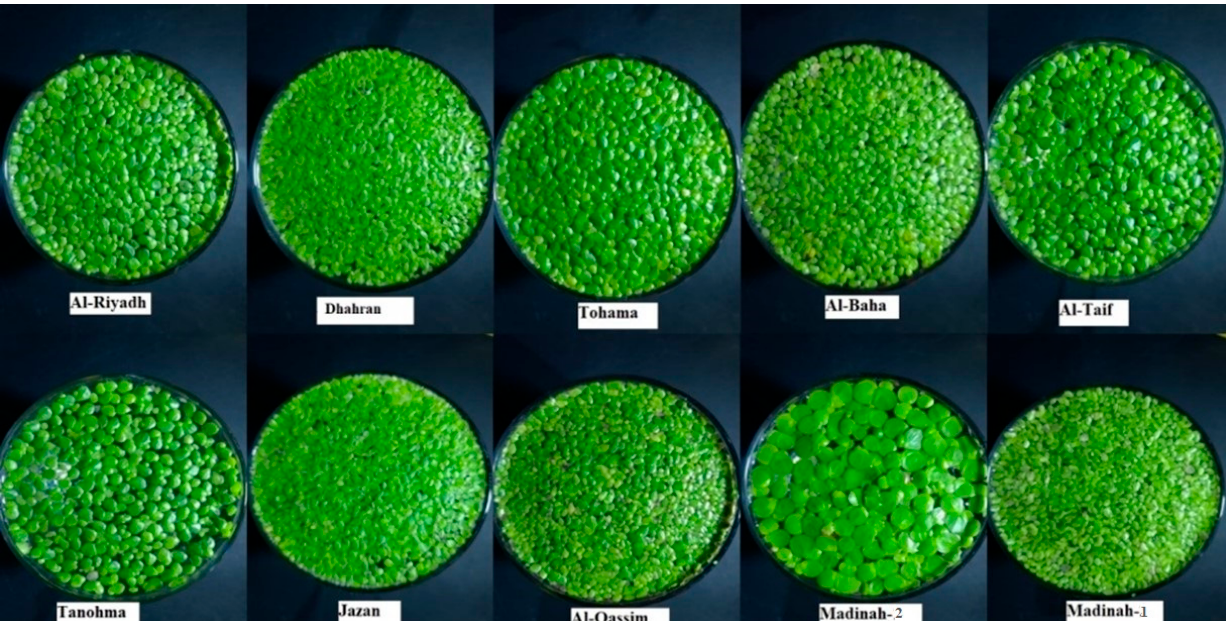
Figure 1. Duckweed clones collected from Saudi Arabia were used for morphological characterization and molecular identification. Table 1. Qualitative morphological traits for studied duckweed clones of the ten locations of Saudi Arabia ( n = 10 samples from each clone averaged and replicated three times, total samples = 30 reads). Frond shape—FSh; frond symmetry—FS; frond color—FC; frond apex—FA; turions—T.